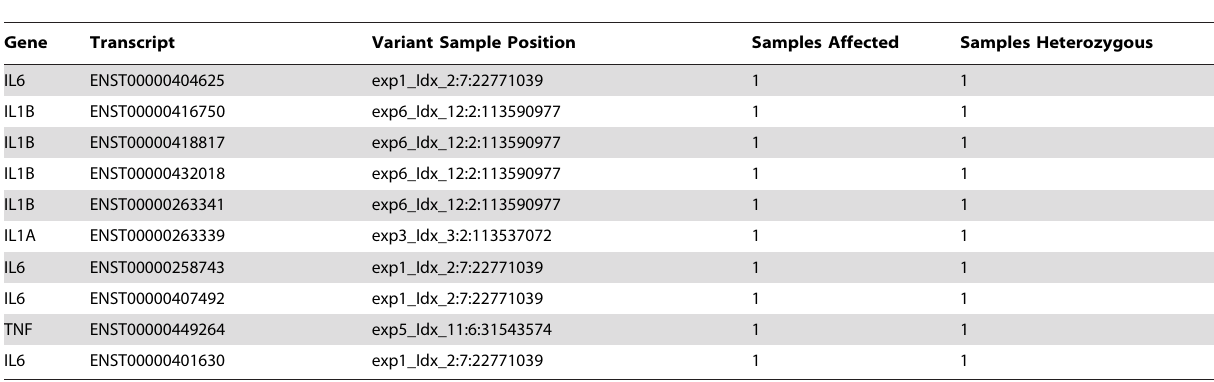
Table 3. Known Implantitis Genes Found in All Variants.